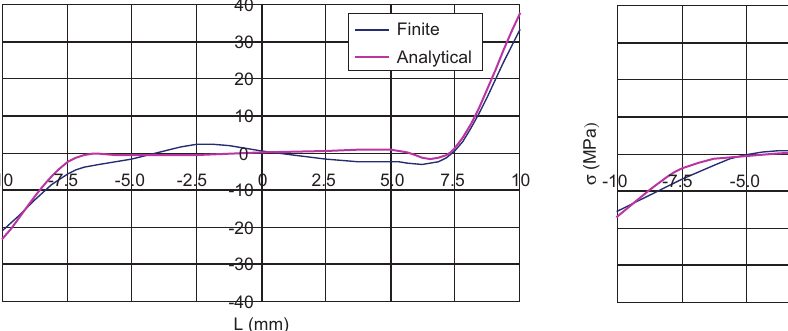
Figure 10 Peel stress distribution along the adhesive for = 2.4 mm. t 0